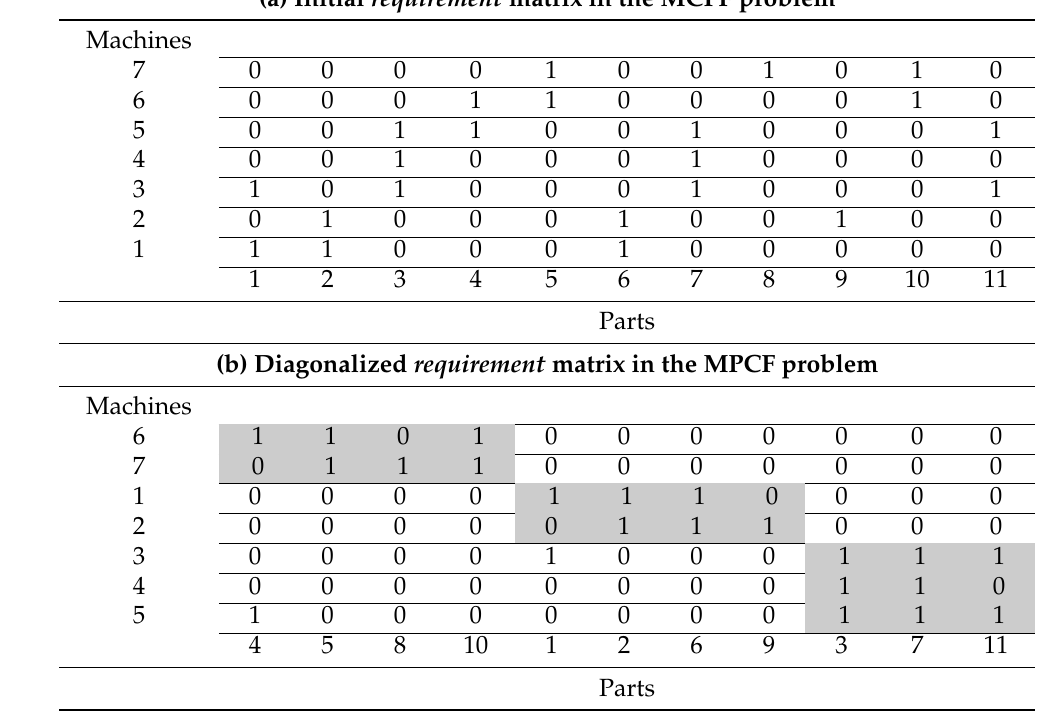
Table 1. Example of matrix rearrangement in the baseline MPCF problem (extracted from [27]). (a) Initial requirement matrix in the MCPF